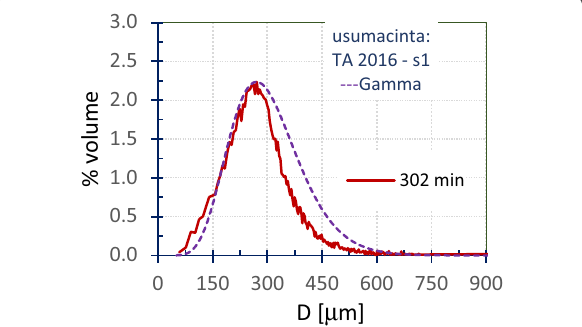
Fig. 7 Floc size distribution at the Usumacinta River from PTV experiments in in the RAF